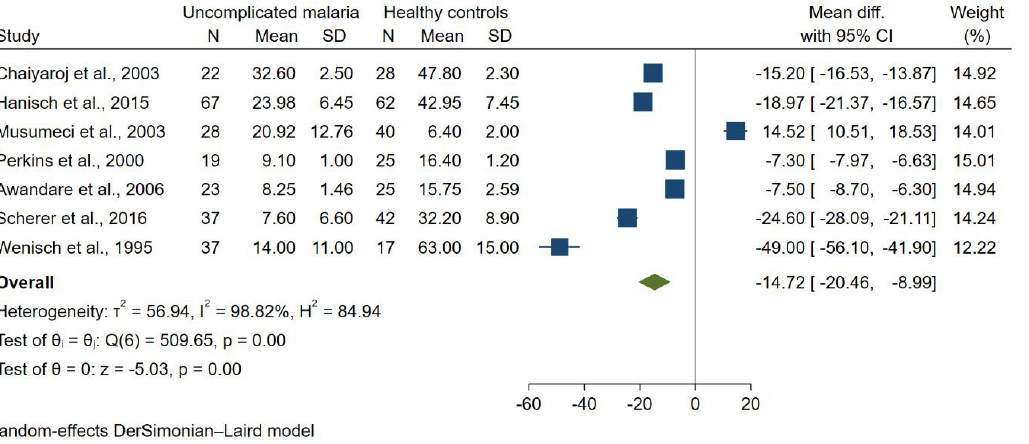
Figure 2. Funnel plot demonstrating a difference in mean TGF-β levels (pg/mL) in uncomplicated malaria and healthy controls [26,27,33,38–40,42]. Grey y -axis line, line of no effect size; blue square boxes, mean TGF-β levels from each study; line on the left and right of blue square boxes, 95% CI; green diamond; overall effect size; I 2 , H 2 and τb 2 , heterogeneity measures; test of θ, overall effect size. Abbreviation: SD, standard deviation.